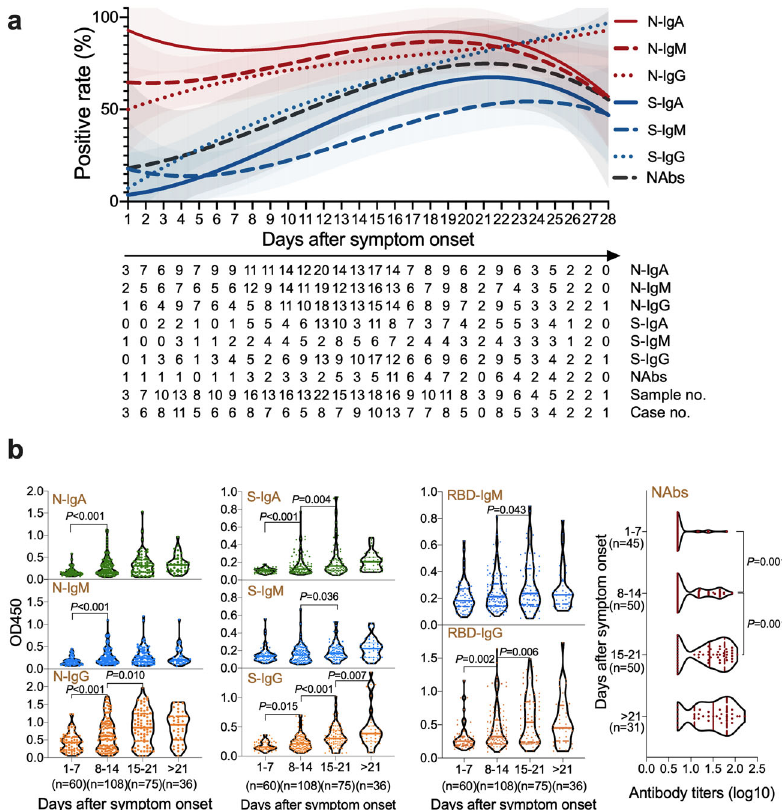
Fig. 1 The characteristics of humoral responses in COVID-19. a The positive rate of IgA, IgM, and IgG antibodies against SARS-CoV-2 nucleocapsid (N), spike (S) proteins and neutralizing antibodies (NAbs) in all the cases between 1 and 28 days after symptom onset. The fi tted curve lines are created by Fit Spline program of Graphpad software where shadows indicating 95% con fi dence intervals. The table below the fi gure denotes the number of samples tested at each time point given in days and the positive rate at each day were used to draw the fi tted curve. b Levels of IgM, IgA, and IgG antibodies and titers of NAbs against SARS-CoV-2 in plasma samples over course of the disease. Antibody titers were expressed as optical density (OD) value and NAbs titers are shown as geometric mean titers (GMTs). The median and quartiles were represented in the violin